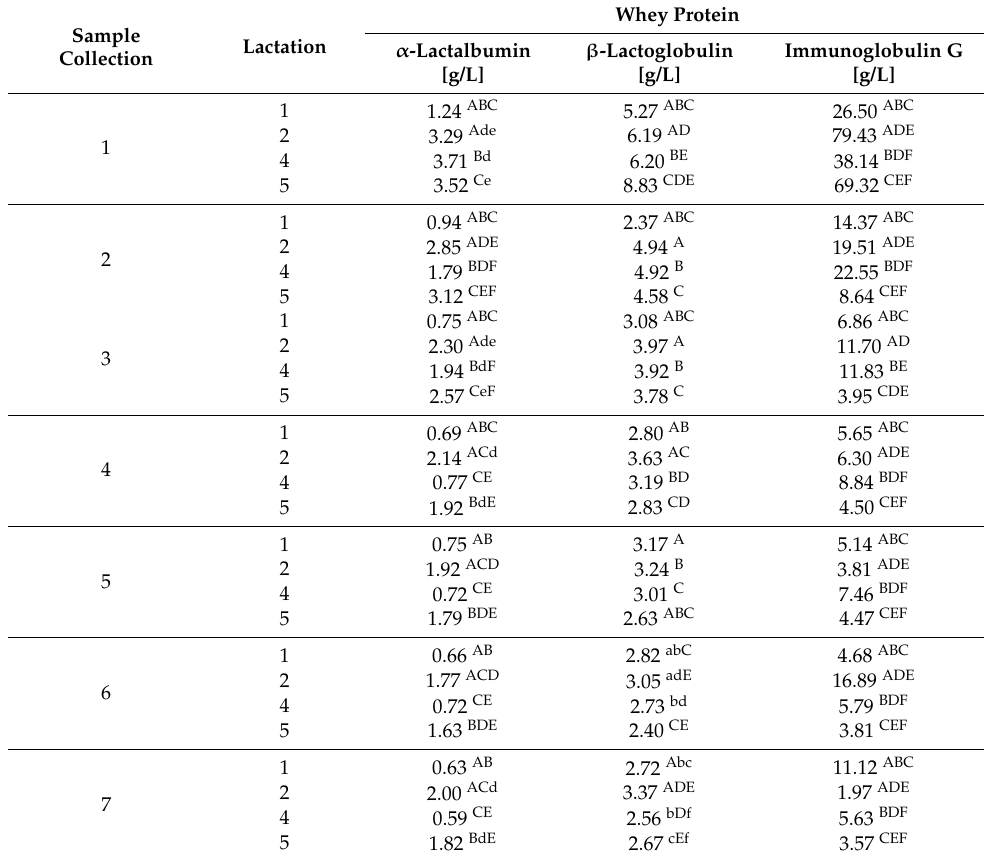
Table 3. Changes in the whey protein values of colostrum for subsequent collections, depending on parity. Data are presented as least squares means. Means marked with the same letters differ significantly at: lowercase letters, p ≤ 0.05; uppercase letters, p ≤